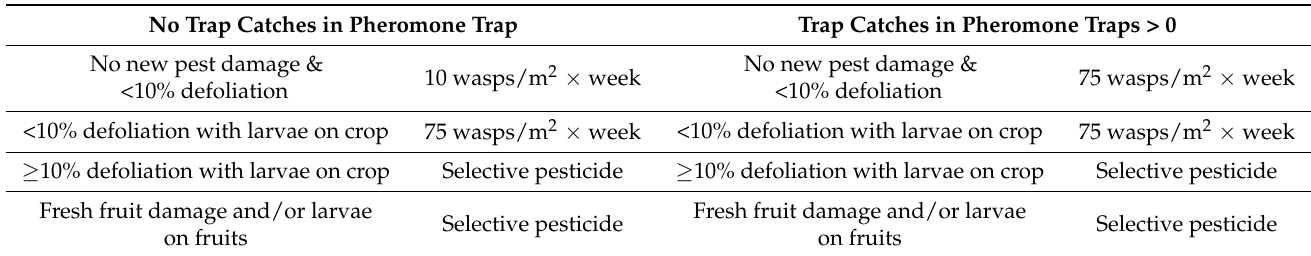
Table 2. Criteria to establish the requirement and rates for parasitoid releases in 2016.